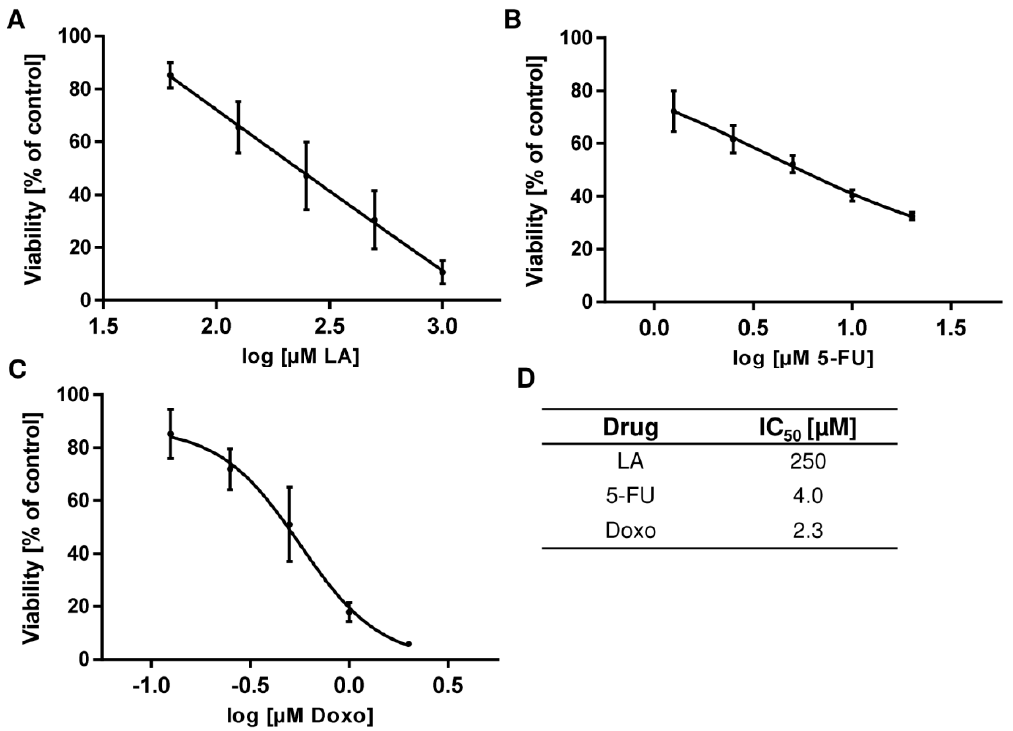
Figure A3. Determination of drug concentrations for application of the Chou Talalay method. HCT116 cells were treated with increasing fixed-ratio doses of LA ( A ) for 120 h; 5-FU ( B ), or Doxo ( C ) for 72 h respectively. Cell viability was measured using ATP assays and normalized to solvent treated control cells. Drug concentrations were transformed into log-scale and plotted against the cell viability. The curve was fitted by non-linear regression with variable slope, providing the IC 50 -values. Data are presented as mean + SEM, n = 2, triplicates. ( D ) Summary of IC 50 -values.